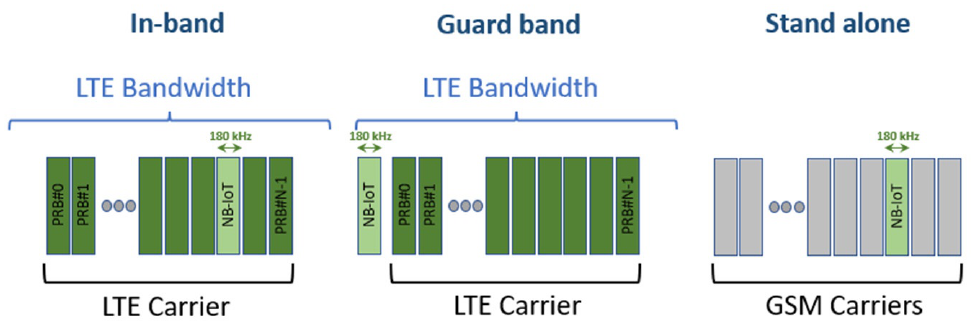
Figure 3. NB-IoT operating modes.